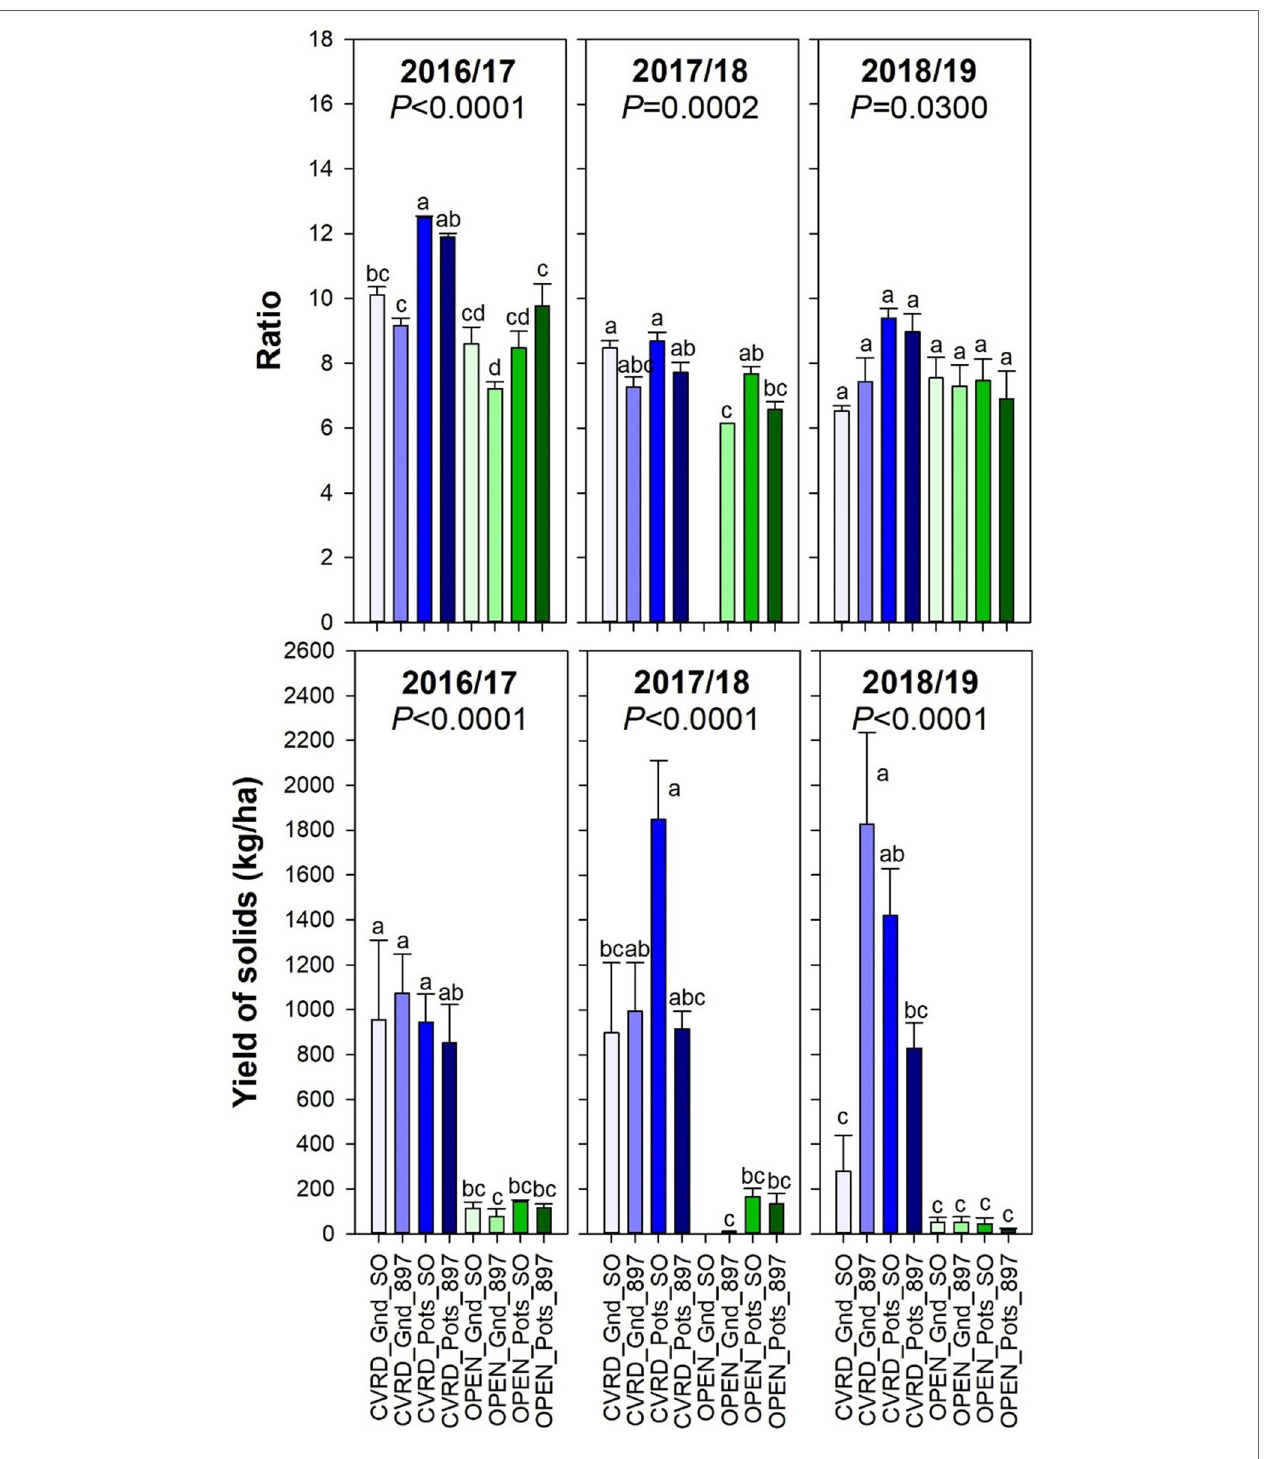
FIGURE 8 | Soluble solids content: titratable acidity ratio (top) and Yield of solids (bottom) of “ Ray Ruby ” grapefruit trees cultivated under two production systems (screenhouse, CVRD and open-air, OPEN), two planting systems (in-ground, GND and potted, POTS), and two rootstocks ( “ Sour Orange, ” SO, and “ US-897 ” ), with four replications arranged in a split-split-plot experimental design. Mean ± standard error of four replications. Means with the same letter are not signi fi cantly different from each other at 5% probability ( P ≤ 0.05) using Tukey mean comparison test. Empty bar on OPEN_Gnd_SO treatment in 2017/18 is related to the absence of fruit for fruit quality sampling in all